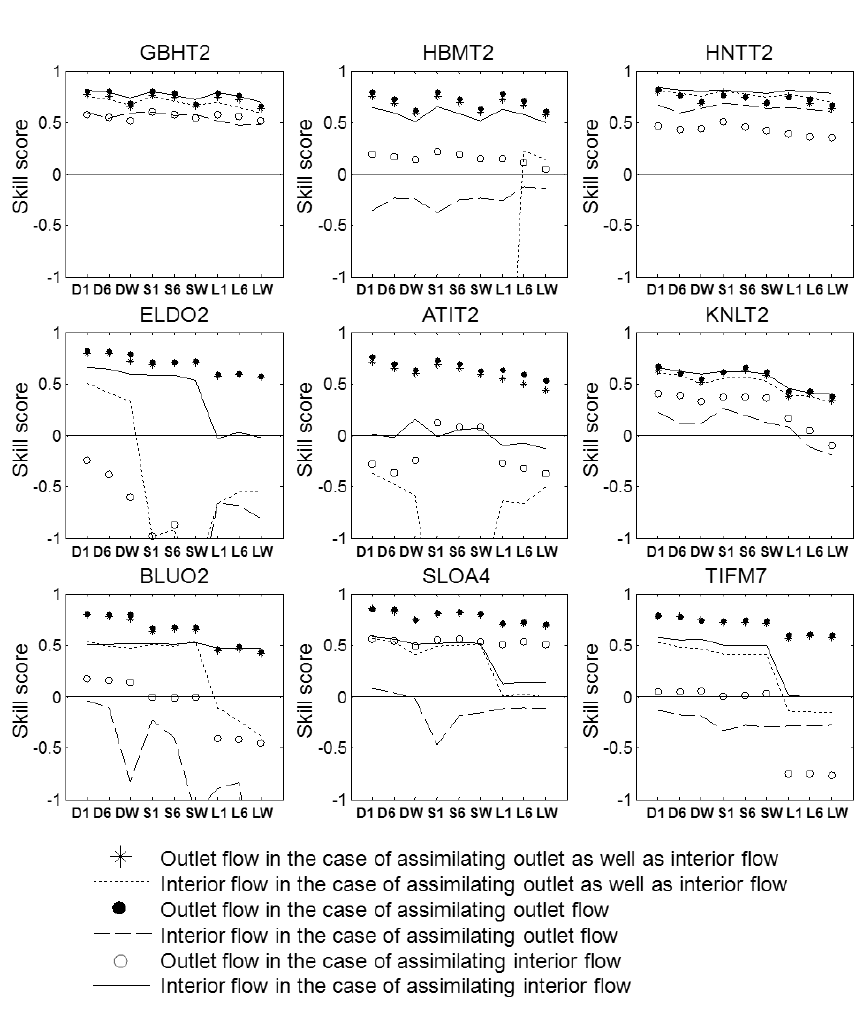
Fig. 5. Mean skill score of streamflow analysis where mean skill score is obtained by averaging mean squared error-based skill score calculated for individual event (D: distributed, S: semi-distributed, L: lumped, 1: 1-h, 6: 6-h, W: the length of time equal to that of the assimilation window). 820 821